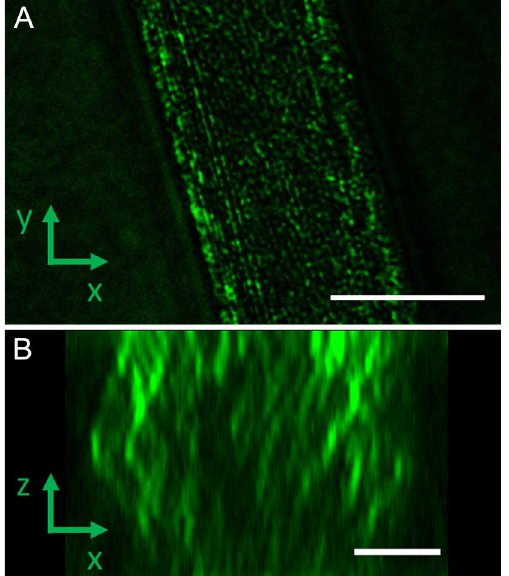
Figure 5. CFRD microscopy images of MiS spider silk fibre. ( A ) Optical slice taken at the middle of a MiS fibre. Scalebar is 5 µm. ( B ) Acquisition of images at different depths in z throughout the sample enabled the reconstruction of a slice through the fibres in the xz plan, showing the fibre cross section. Scale bars 2 µm.